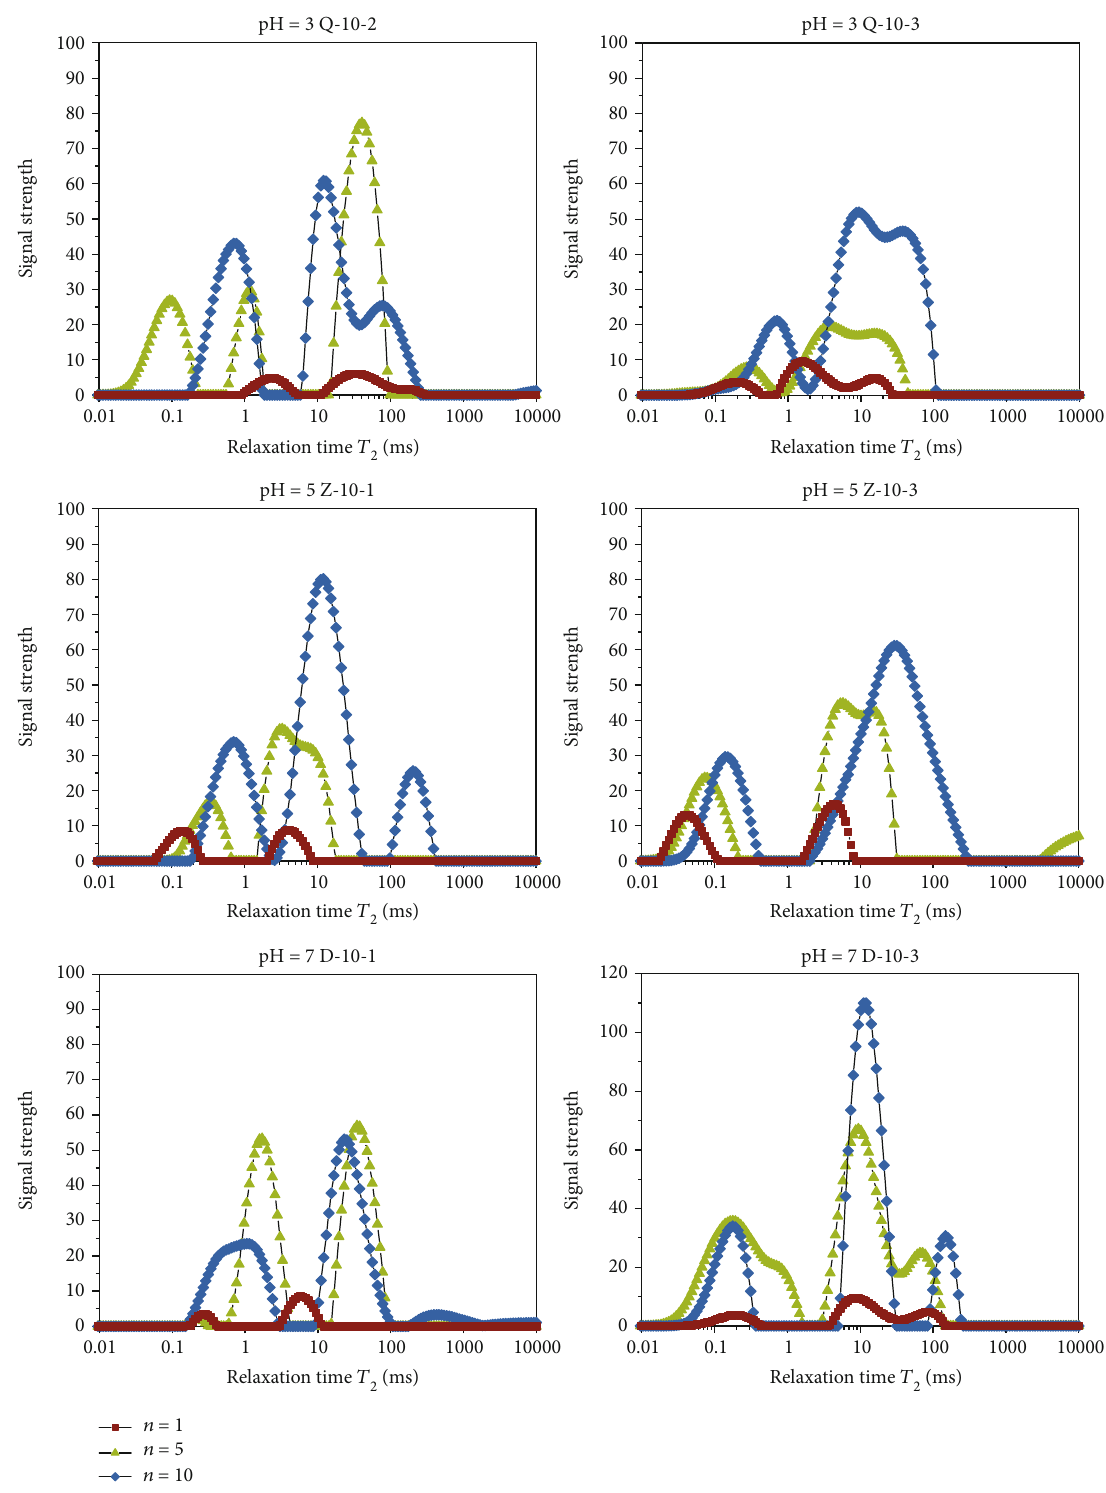
Figure 4: Variation in the T spectrum distribution of limestone under di ff erent dry-wet cycles and di ff erent pH 2